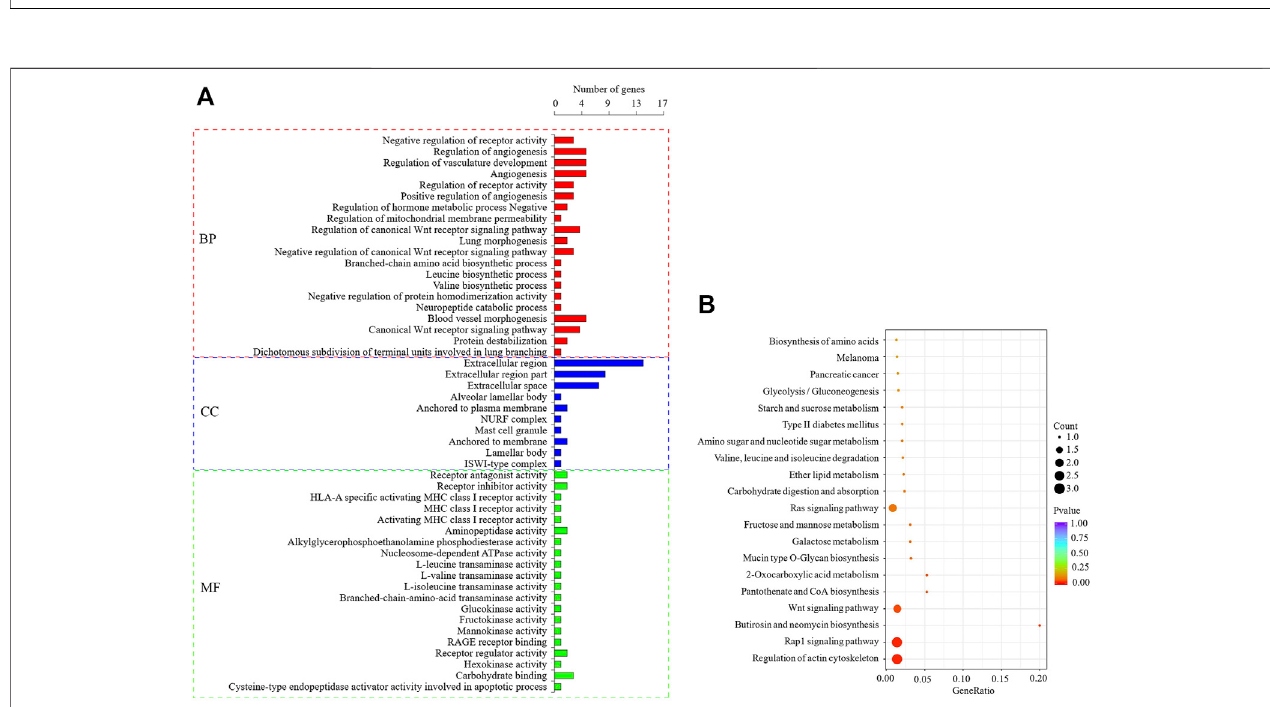
FIGURE5| GOandKEGGenrichmentanalysisofDEGs. (A) :The fi rst20signi fi cantGOitems( p < 0.05),whenlessthan20,onlyshowsigni fi cantenrichmentitems, the latter is the same. (B) : The fi rst 20 KEGG enrichment results.